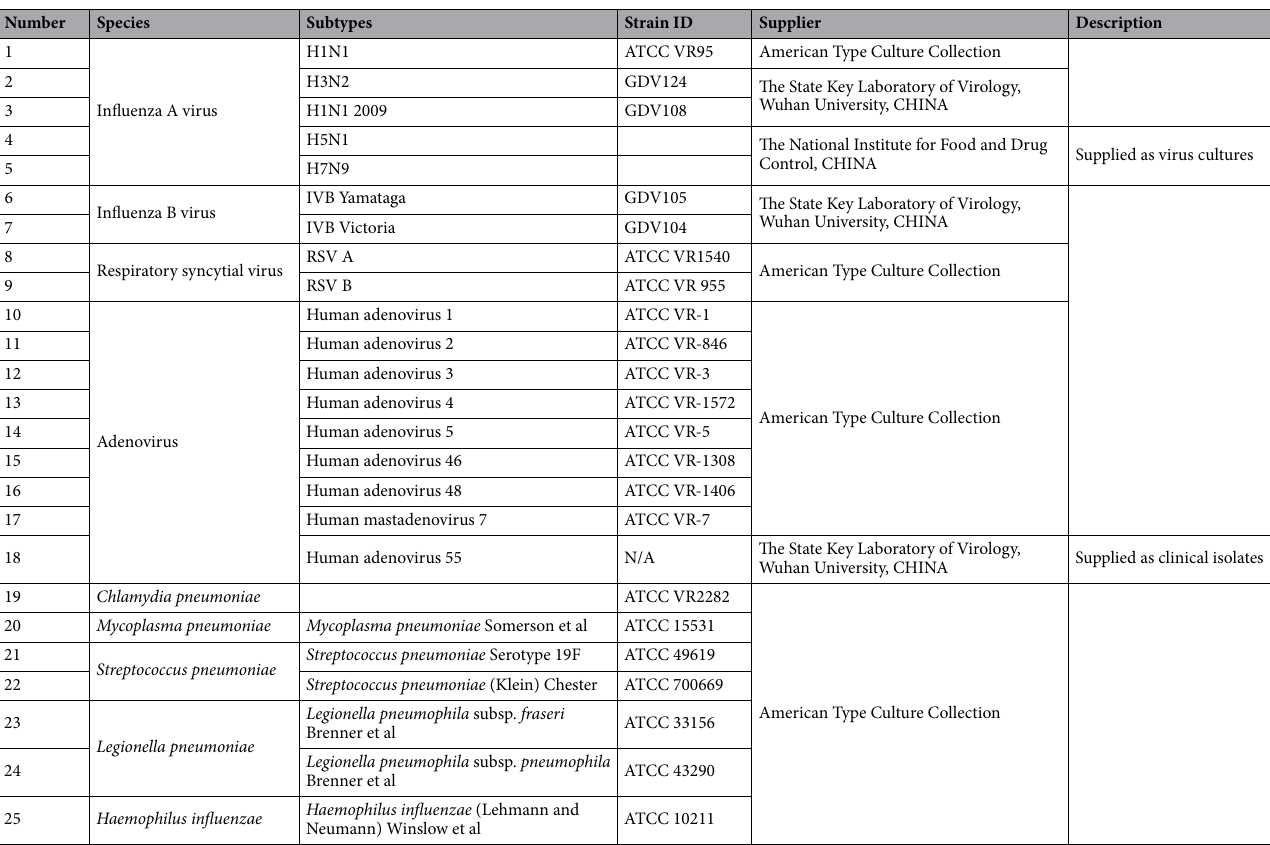
Table 5. Pathogenic microorganisms, including culture strains and laboratory isolates, used as the target pathogens in the evaluation of three-tube multiplex real-time